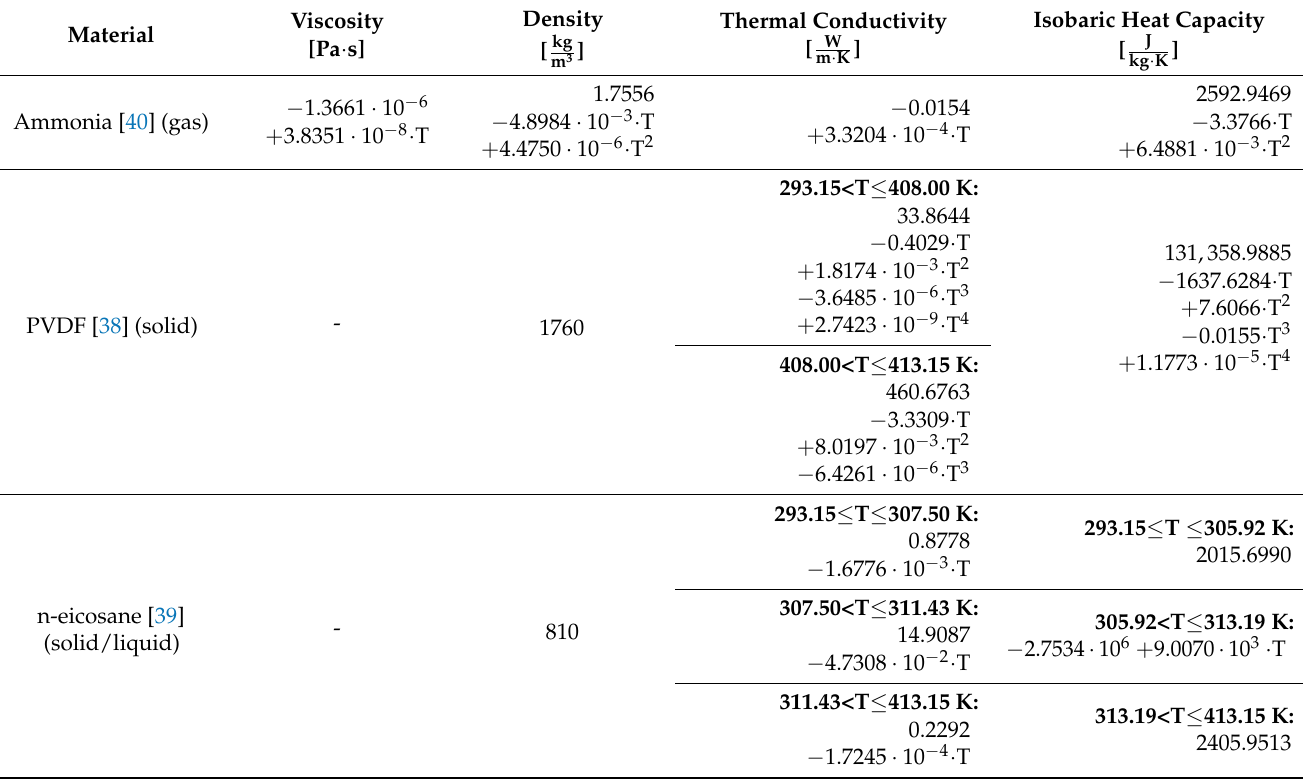
Table 1. Material properties used in the CFD simulations; the polynomial functions are given with respect to the temperature (T) in Kelvin and are valid in the range of 293.15 to 413.15